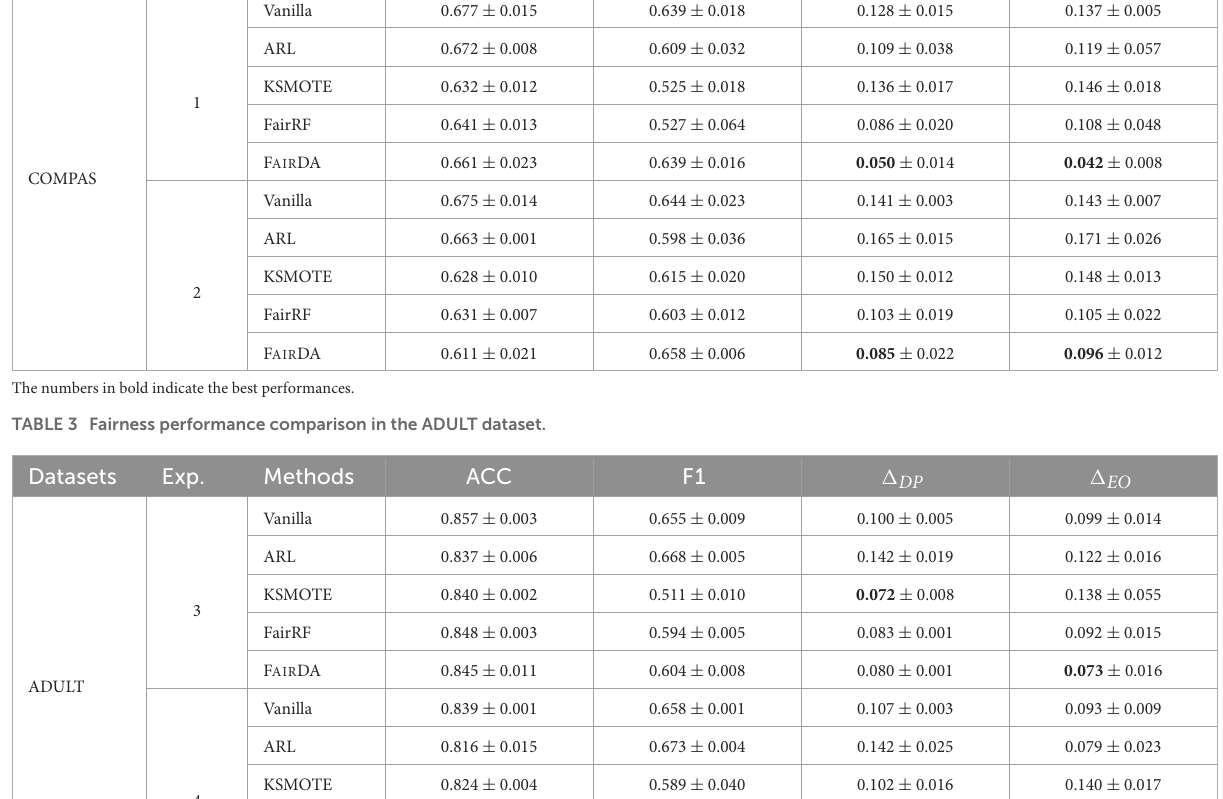
TABLE 2 Fairness performance comparison in the COMPAS dataset. Datasets